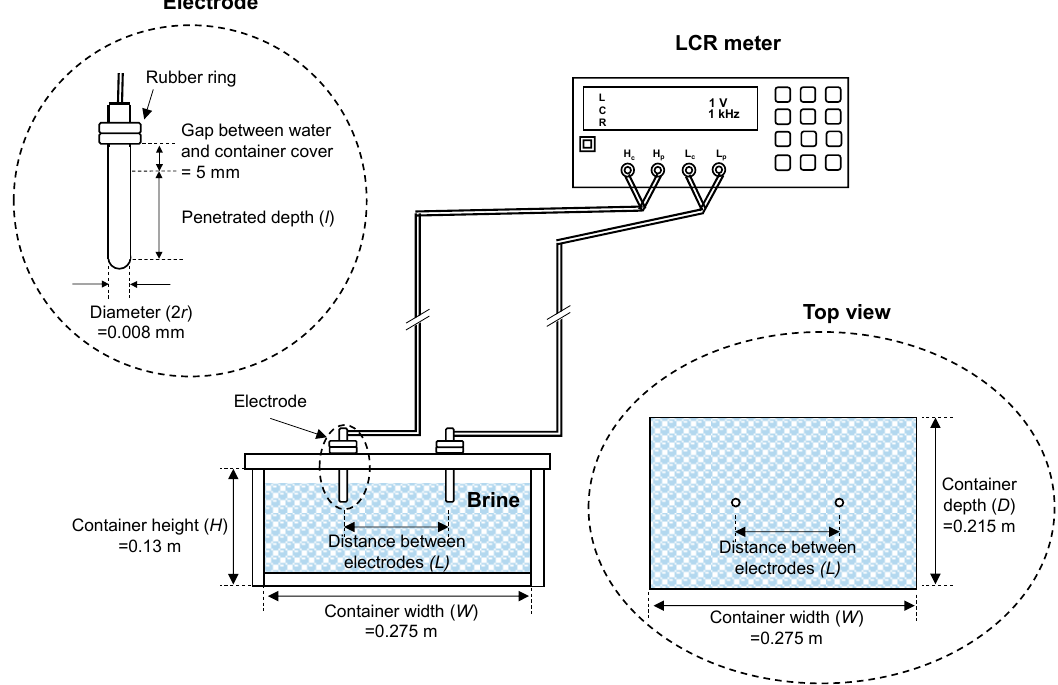
Figure 3. Test setup: measurement equipment, container and electrodes. Table 1. List of experimental test cases.